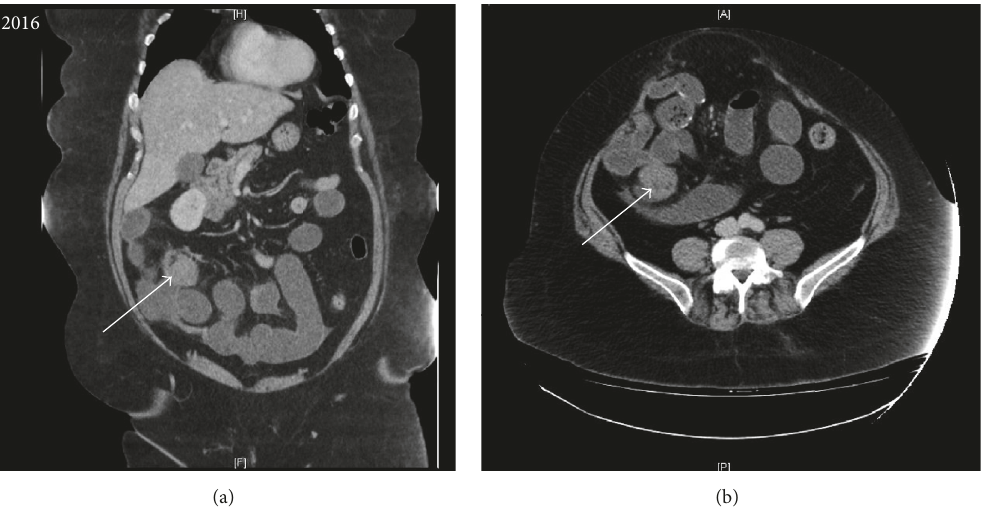
Figure 2: Coronal enhanced (a) and axial enhanced (b) CT performed 4 years later, showing recurrent hypovascular solid mass (white arrow) in the mesentery of the right lower